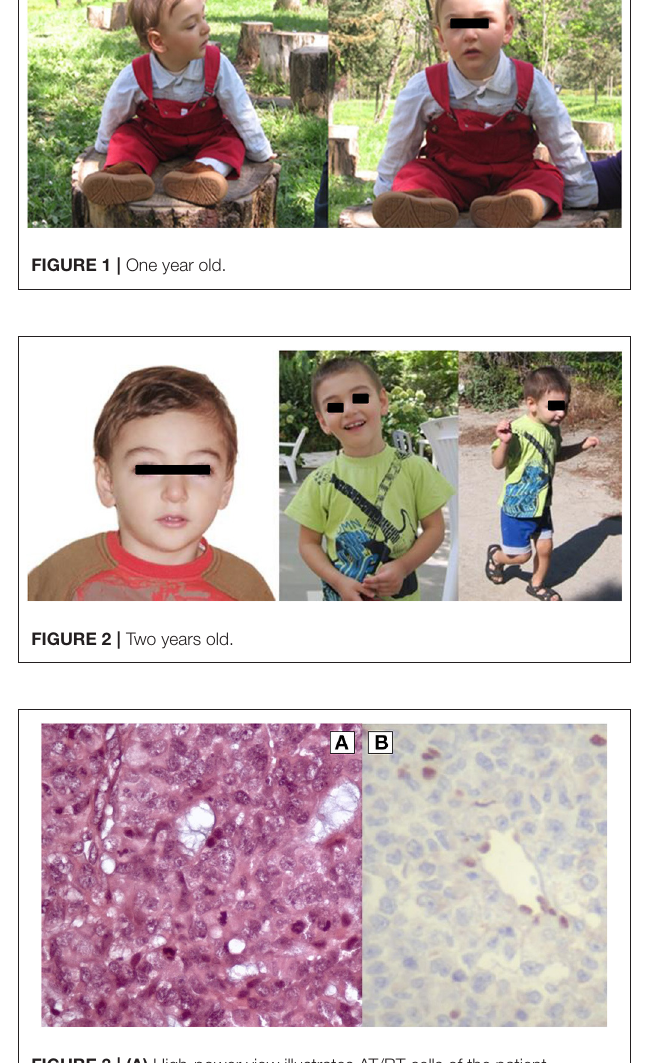
FIGURE 3 | (A) High-power view illustrates AT/RT cells of the patient (hematoxylin and eosin staining). (B) Rhabdoid cells negative for SMARCB1 protein